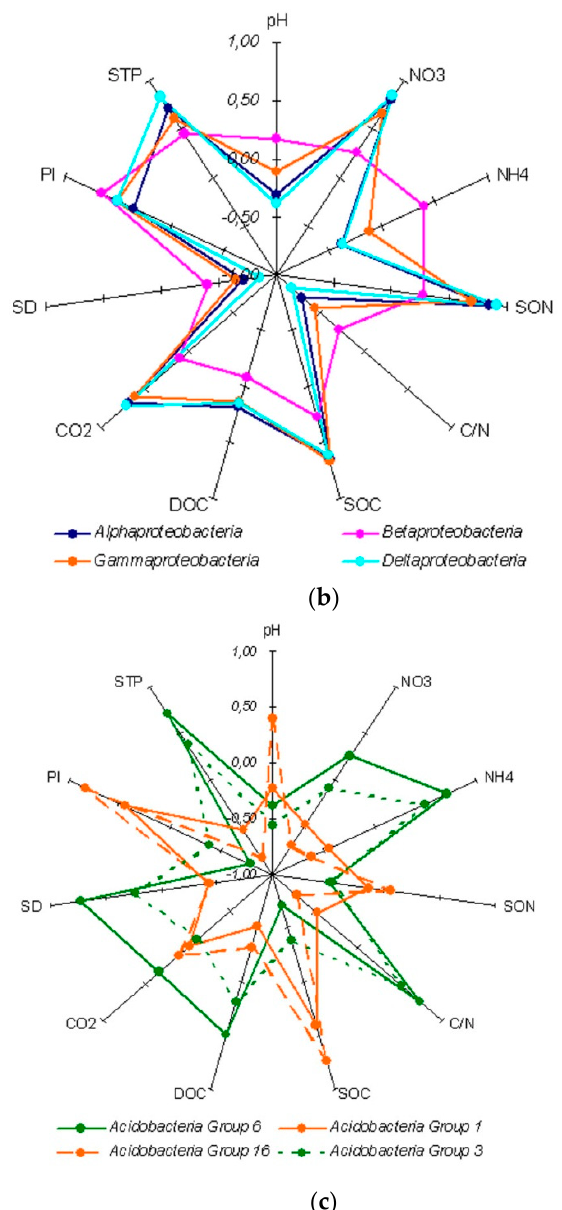
Figure 3. Correlation coefficients (Spearman’s) between soil properties and relative abundance of dominant bacterial phyla ( a ), Proteobacteria classes ( b ) and the dominant Acidobacteria classes ( c ). The coefficients exceeding │ 0.51 │ are statistically significant at p ≤ 0.05 level. Abbreviations used: